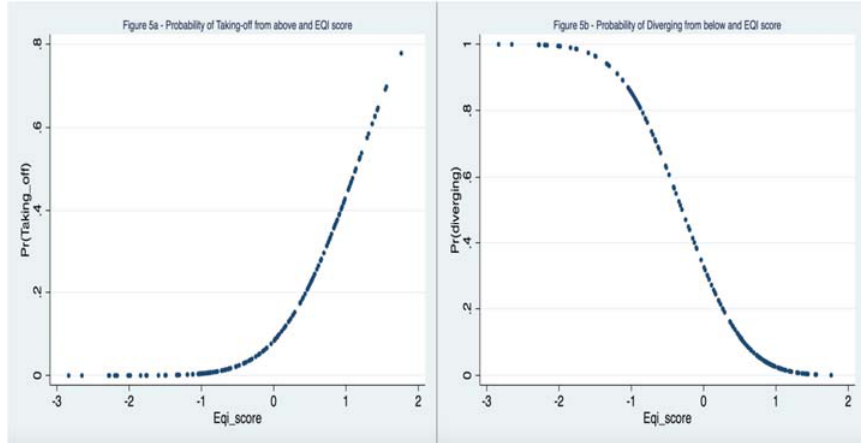
Figure 5 . Probability of “taking-off” from above and “diverging” from